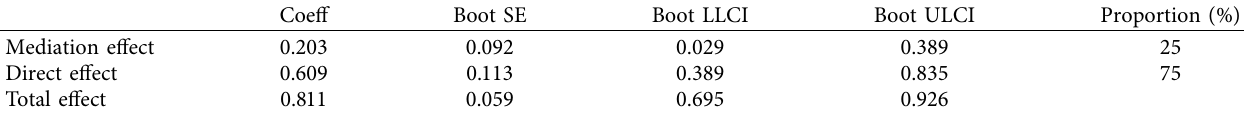
Table 6: Bootstrapping analysis results of mediation effect and its